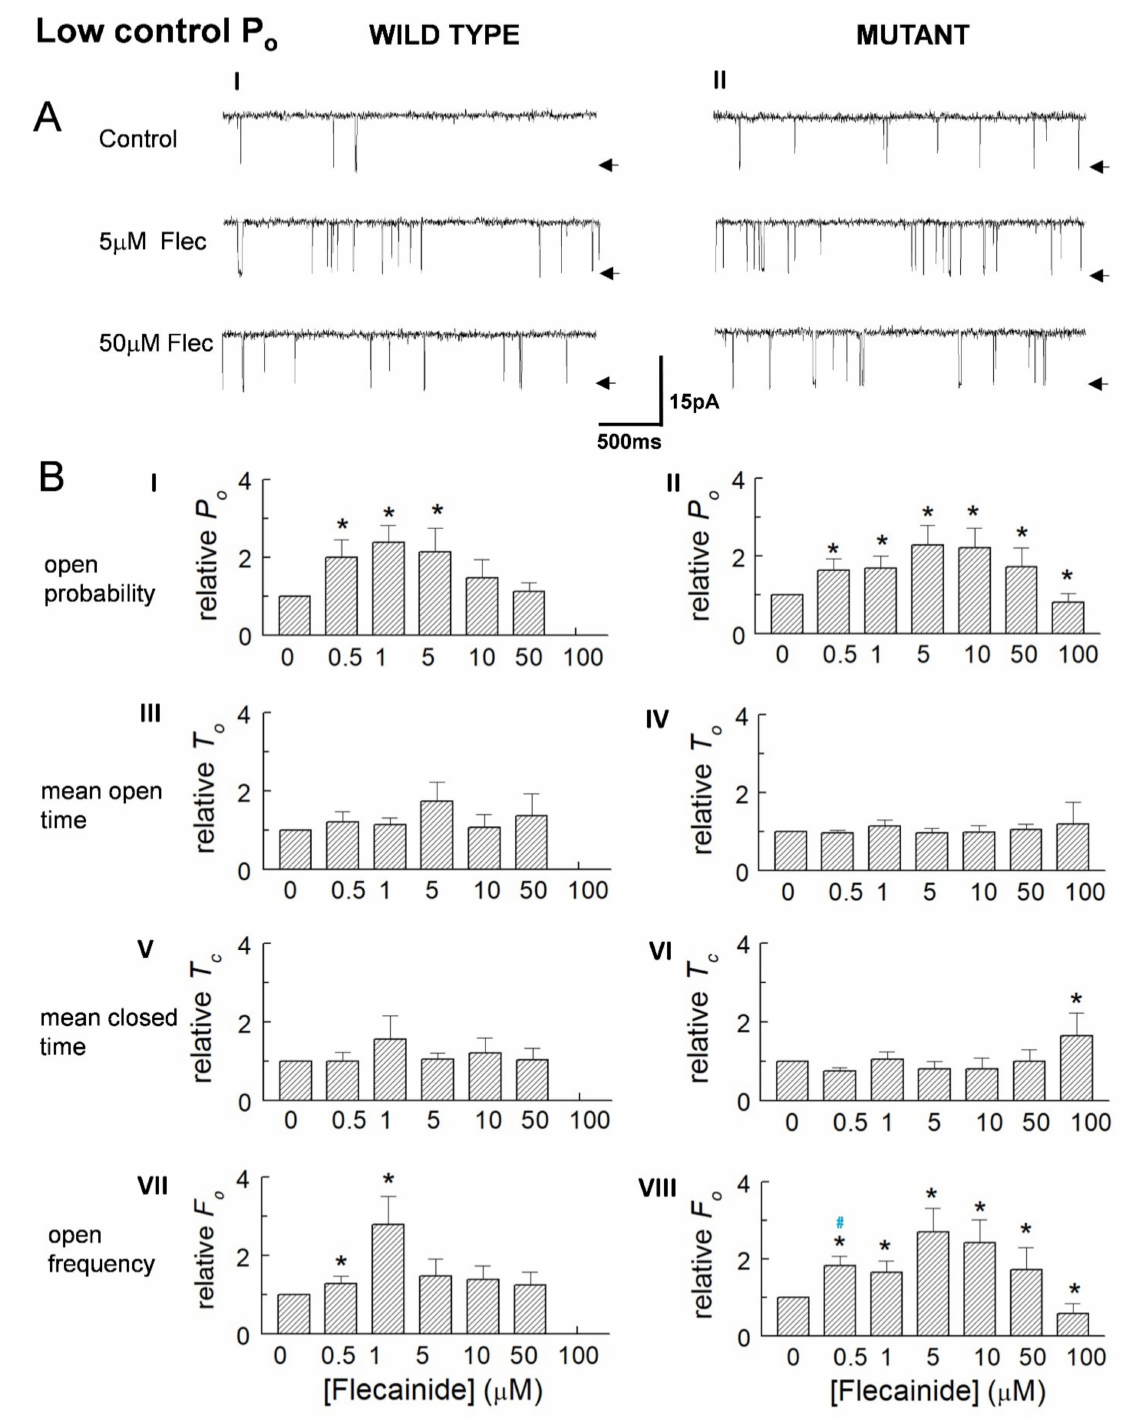
Figure 4. Increased activity of low control open probability ( P o ) wild type (WT) and P2328S channels. ( A ) Average relative P o ( A ) (I,II), mean open time ( T o ) ( A ) (III,IV), mean closed time ( T c ) ( A ) (V,VI) and open frequency ( F o ) ( A ) (VII,VIII) for WT ( n = 10) and P2328S ( n = 11). ( B ) Average parameter values for WT ( B ) (I) and P2328S ( B ) (II). WT channels were not exposed to 100 µ M flecainide. In ( B ) data is mean ± SEM. (*), significant ( p < 0.05) change from control. Blue # , significant ( p < 0.05) difference between WT and